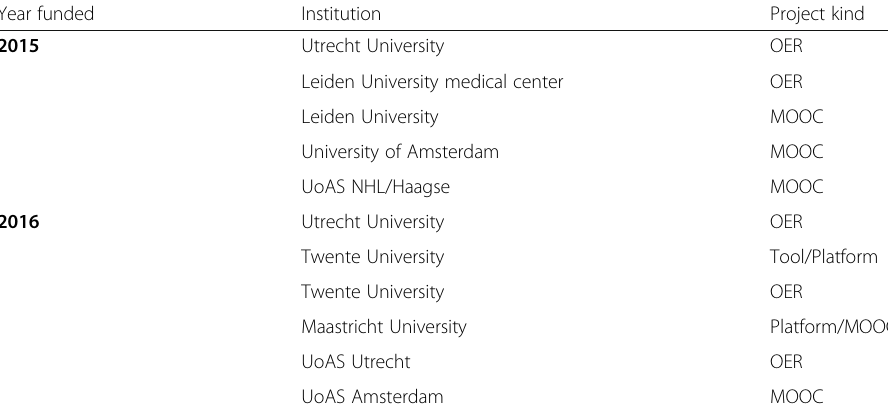
Table 2 Sample description (UoAS: university of applied sciences) Year funded